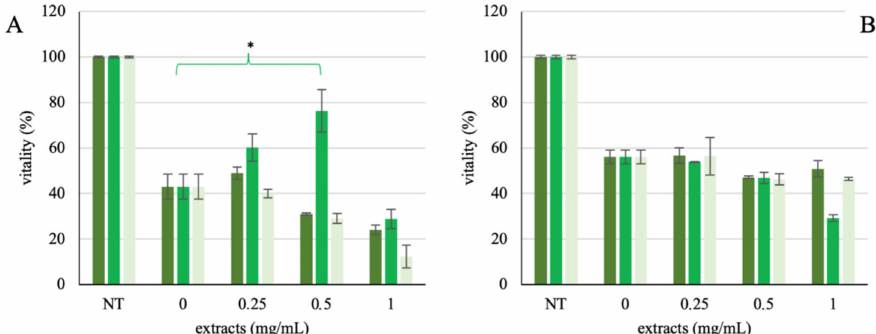
Figure 5. Vitality rescue of HT-29 cell line co-treated with stressor compounds and different extracts. The figure represents the viability rescue of the HT-29 cell line stressed with H 2 O 2 ( A ) or SDS ( B ) in presence of Maitake preparation ( ), fermented Maitake water extract ( ), and fermented basal medium extract ( ). Values are represented as mean value of vitality % ± standard error. Statistical differences were calculated using Dunnett’s multiple comparisons test: * p -value <